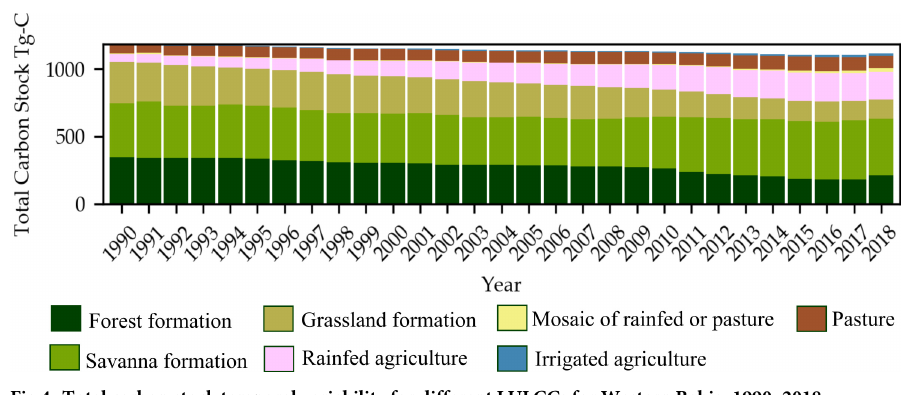
Fig 4. Total carbon stock temporal variability for different LULCCs for Western Bahia,